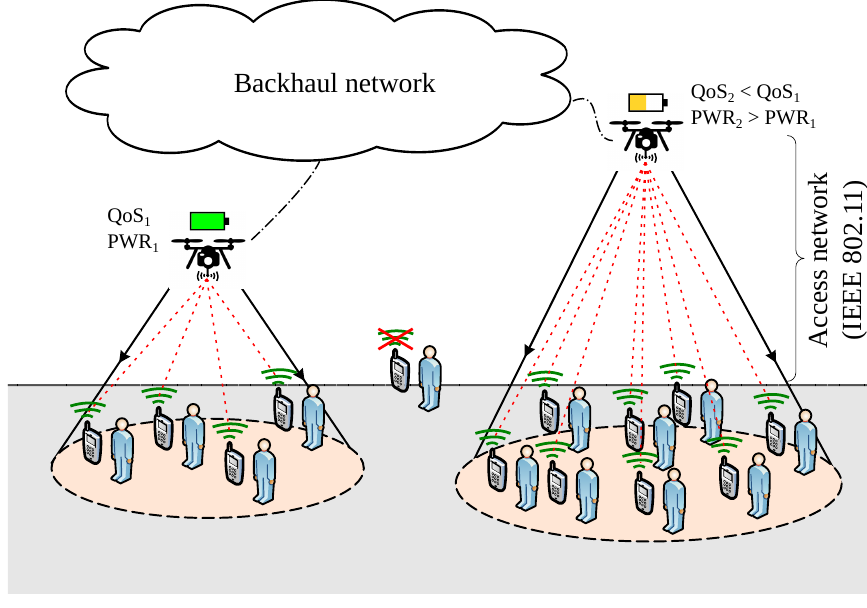
Figure 1. UAV-based VoWiFi